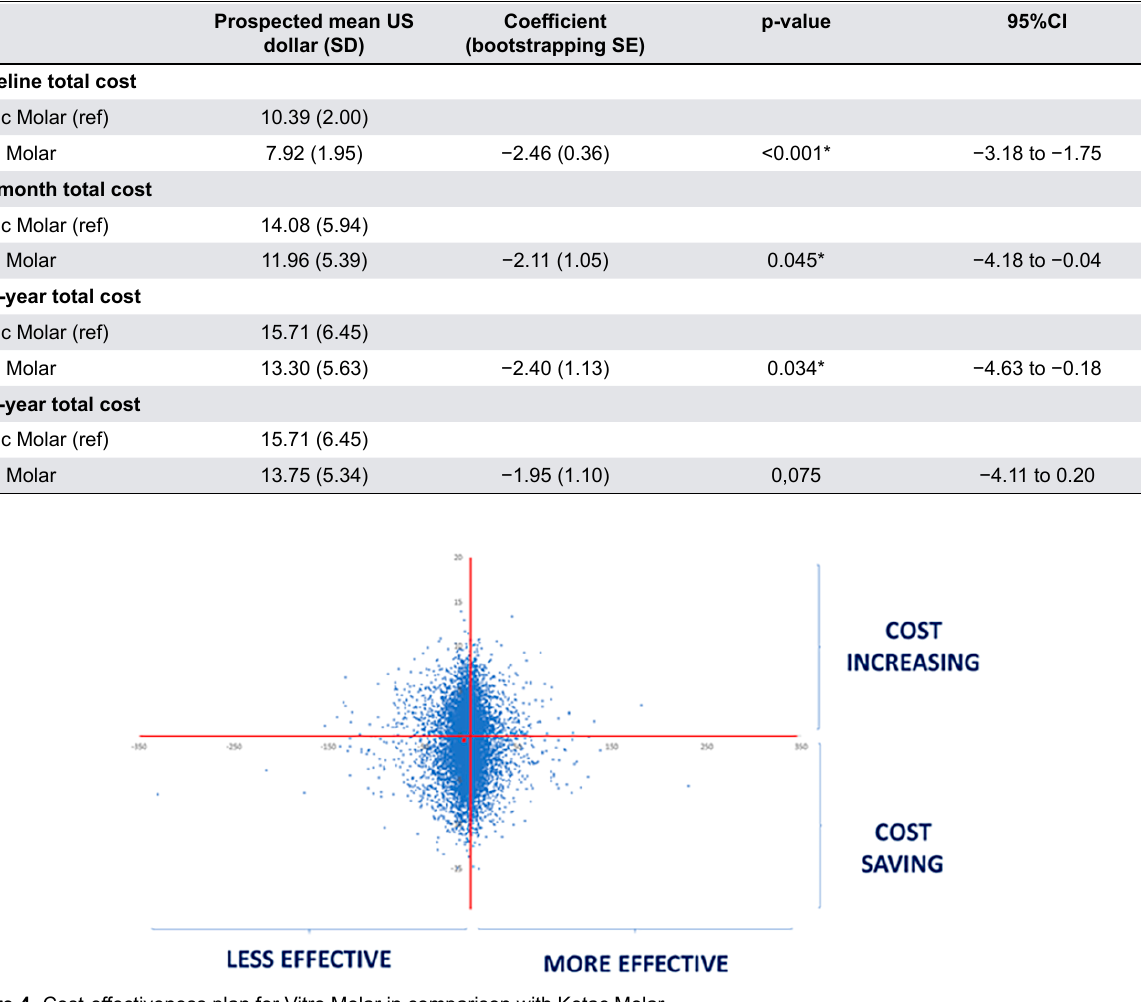
Figure 4- Cost-effectiveness plan for Vitro Molar in comparison with Ketac